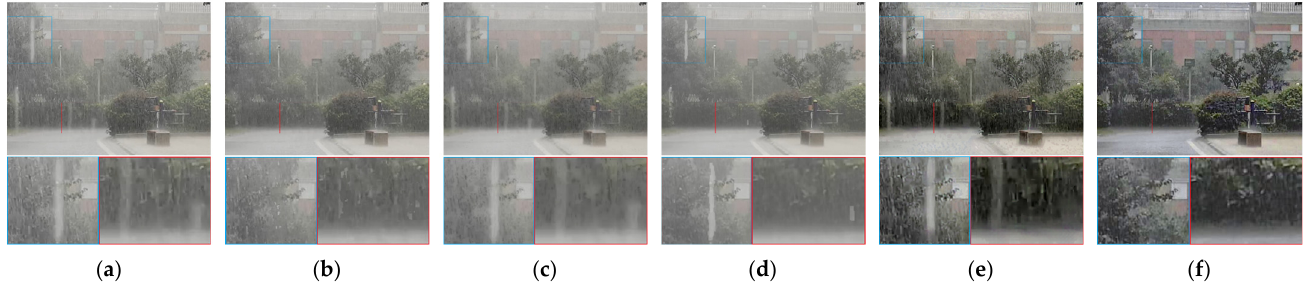
Figure 11. Comparison on a real rain video. ( a ) Input, ( b ) Kim et al. [16], ( c ) Wang et al. [8], ( d ) Li et al. [14], ( e ) Chen et al. [32], ( f ) proposed method.